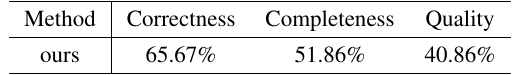
Table 5. Road crack extraction results on CRR